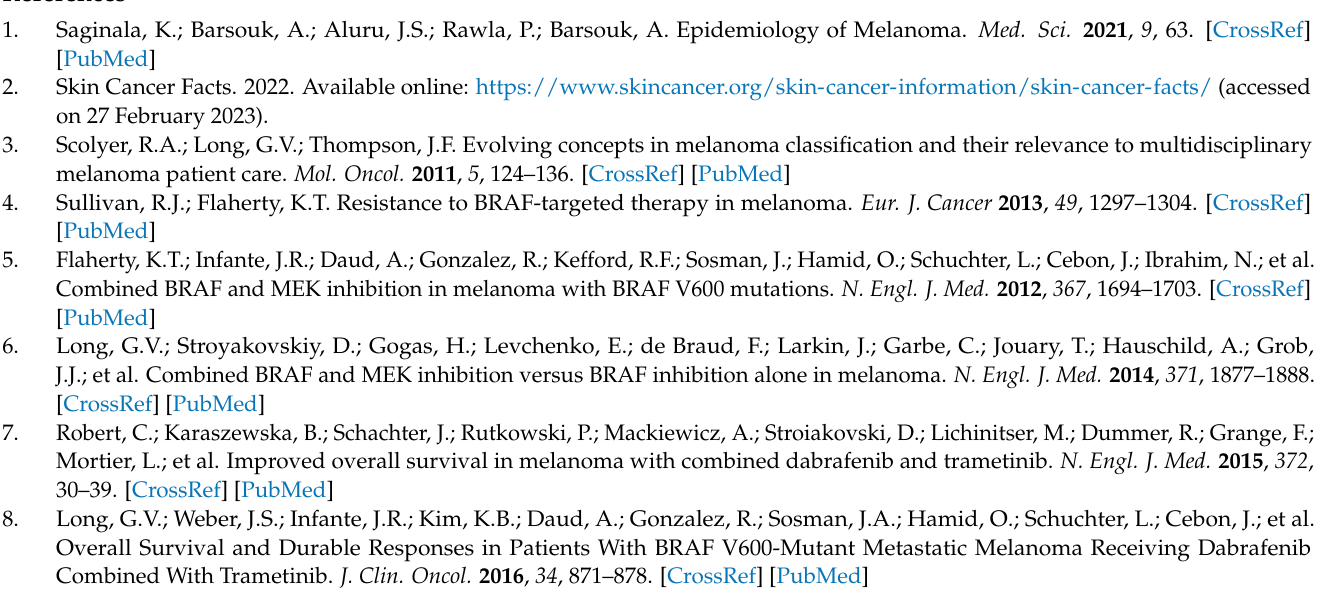
Table S2. S Second-line